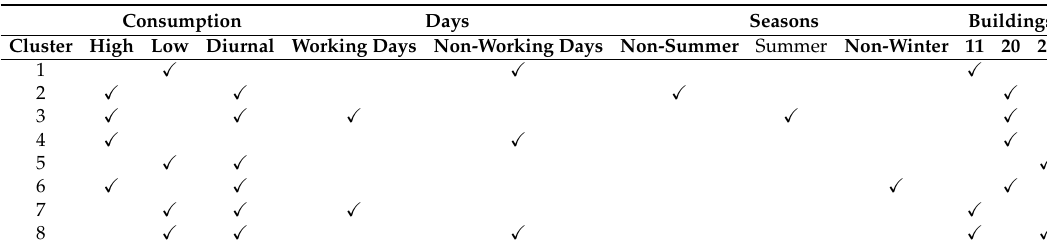
Table 7. Cluster analysis for eight